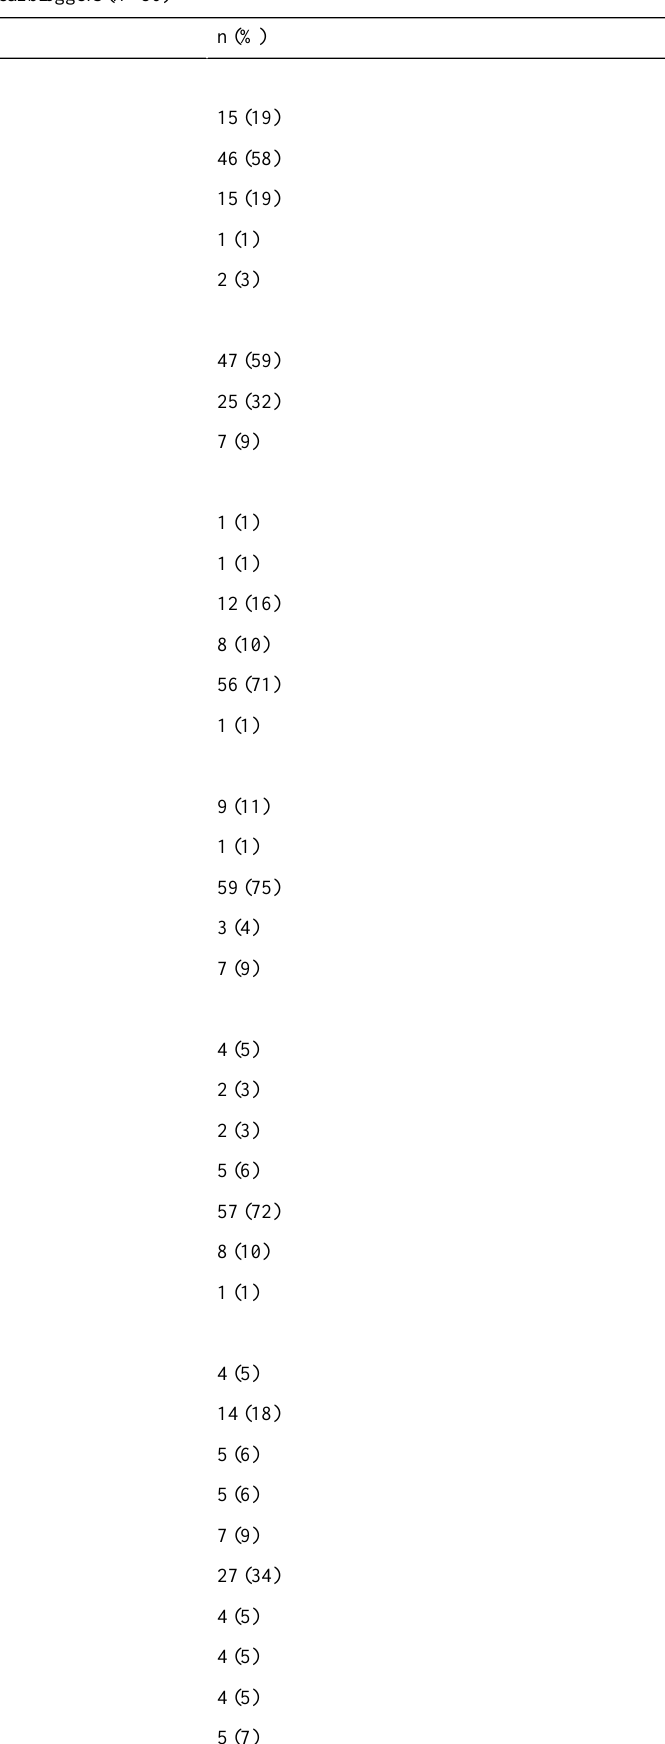
Table 2. General demographic characteristics of the responding medical bloggers